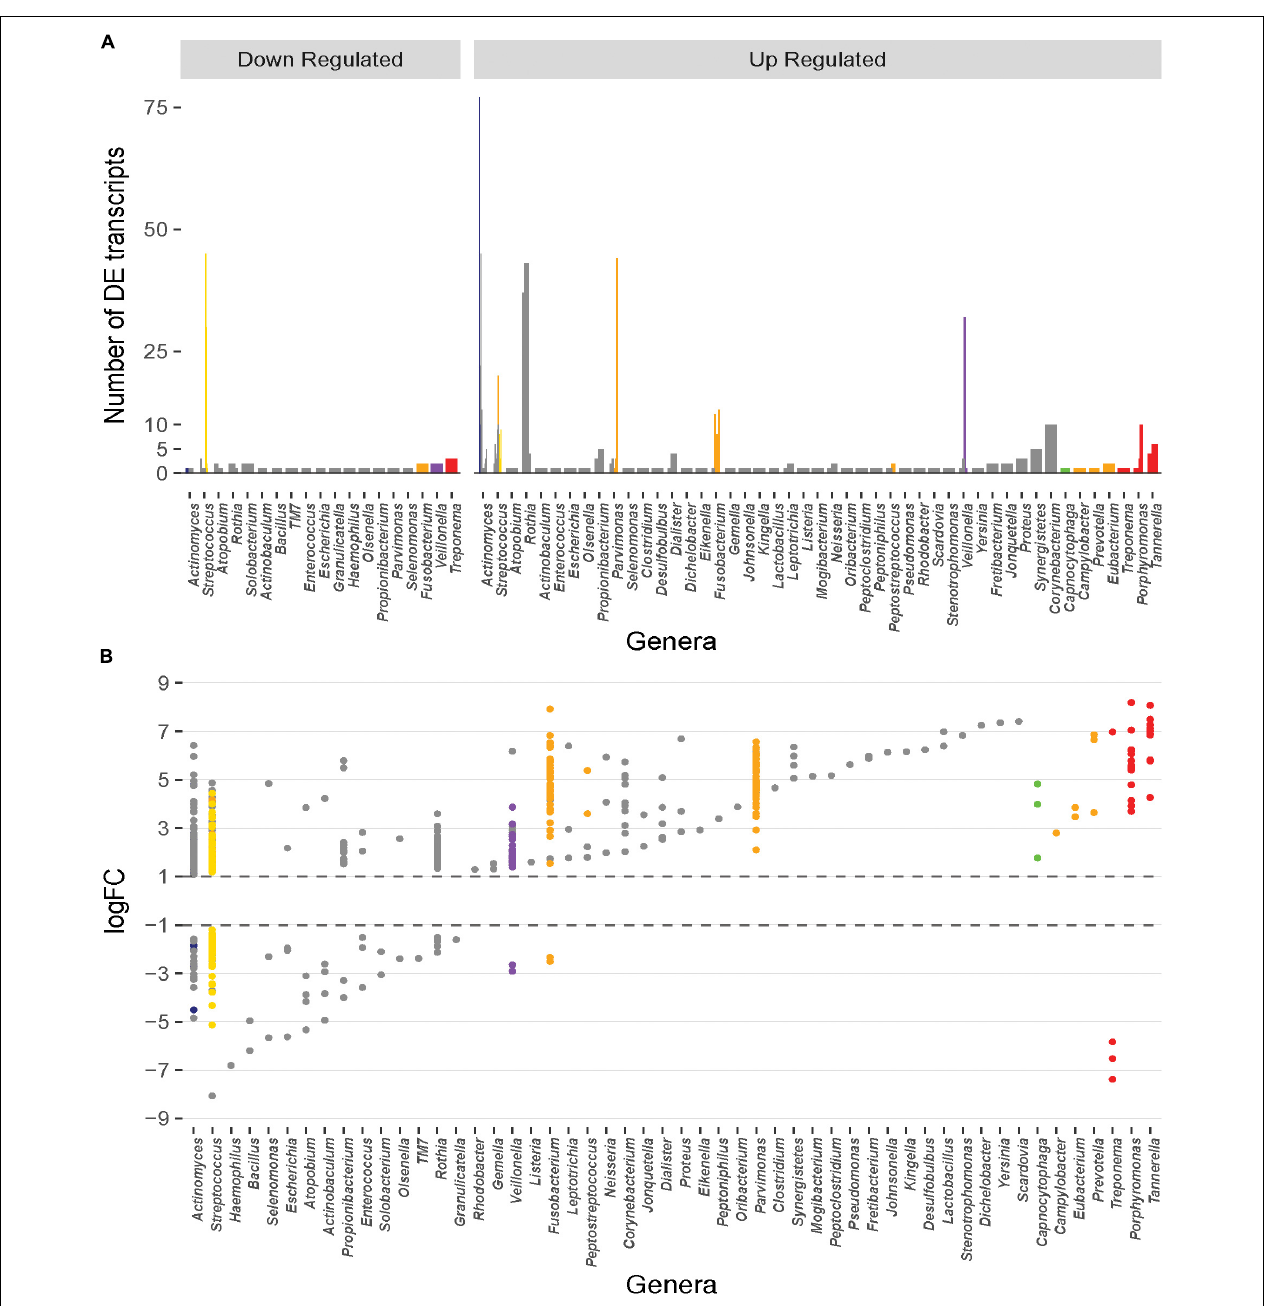
FIGURE 1 | Distribution of the number and magnitude of differentially expressed (DE) transcripts in the genera represented in the oral microbiome. (A) The number of DE transcripts originating from different genera. Juxtaposed lines represent different species within a genus that have DE transcripts. Bars are colored based on the classification of the organism into periodontitis associated complexes (Socransky et al., 1998). Actinomyces and Streptococcus are the genera with the largest number of different species that undergo differential expression during disease. (B) Magnitude of up- or down-regulation (Log 2 fold-change) of the transcripts during disease. Each point represents a DE transcript and points are colored by the complex in which the organism is classified (Socransky et al., 1998). A large fraction of the differentially transcripts originate from organisms that are unaffiliated to a specific disease associated complex. Transcripts from members of the red and orange complexes undergo higher magnitude differential